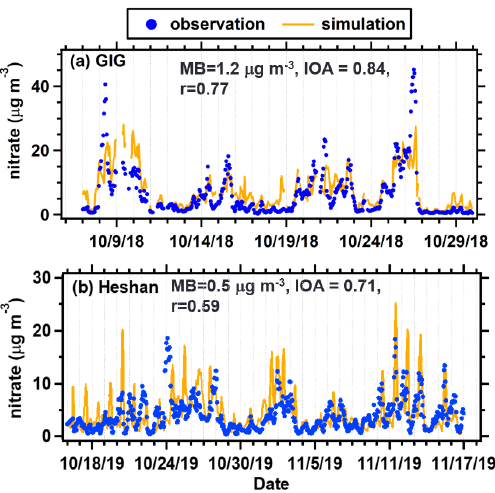
Figure 8. Comparison of the temporal box model simulated and observed nitrate at the (a) GIG site and (b) Heshan